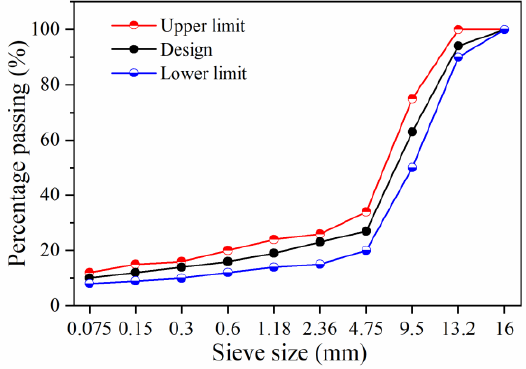
Figure 2. SMA-13 design